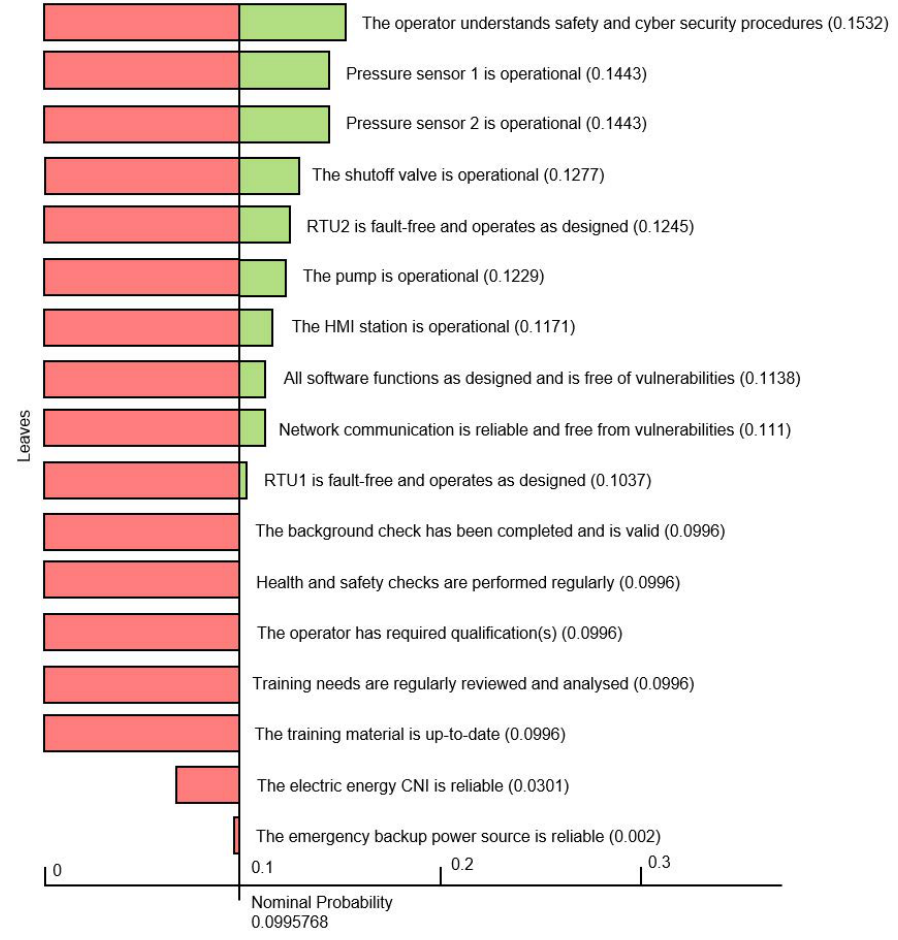
Figure 8. Three-Point Sensitivity Graph for the Water Distribution SCADA